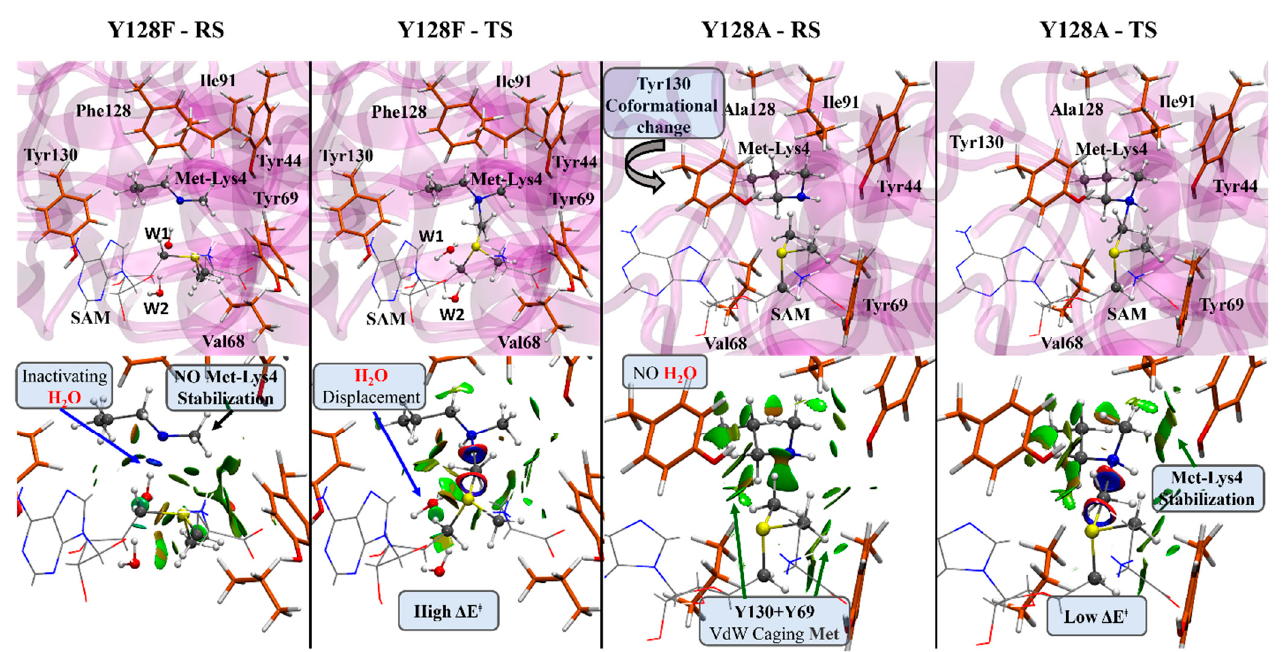
Figure 3. Structural representation of the catalytic site at RS and TS for the di-methyl-transfer reaction performed by the Y128F and Y128A mutants. Below, there is a graphic representation in real space of the non-covalent interactions occurring between the methyl group and the enzymatic environment, showing the mechanism for the reactivation of the enzyme through the Y128A mutant ( Δ E ≠ stands for barrier heights; enzyme’s carbon—orange; substrate and cofactor carbon—gray; red—oxygen; blue—nitrogen; white—hydrogen; and the isovalue used as cutoff for the surface is defined as 0.5). The Y44A and Y128A mutants, on the other hand, presented a remarkable